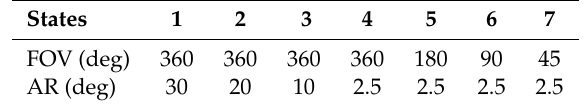
Table 2. The values are assumed for the parameters of the customized gamma